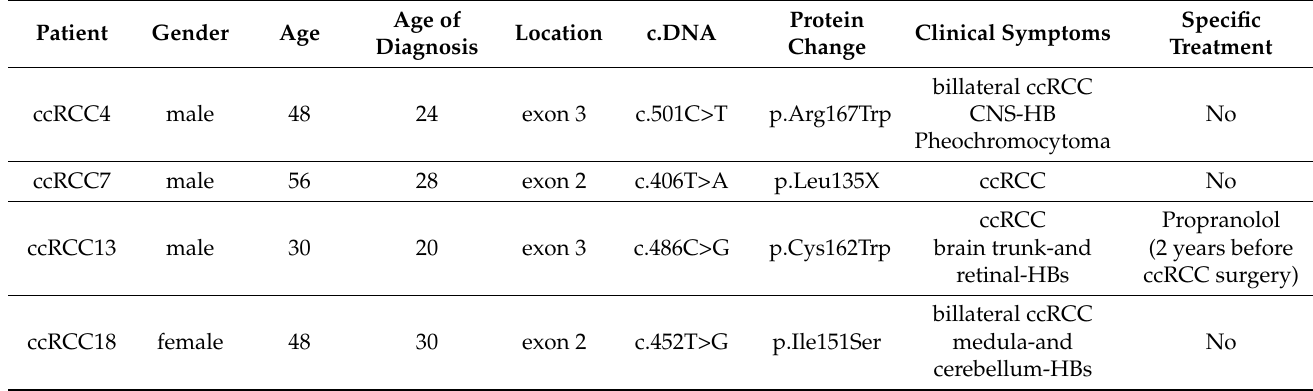
Table 1. Genotypes and Phenotypes of the VHL